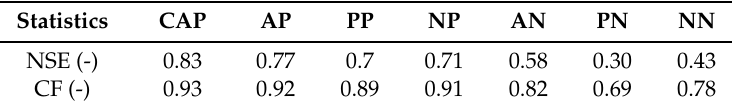
Table 4. NSE and CF in the validation period for the seven models.